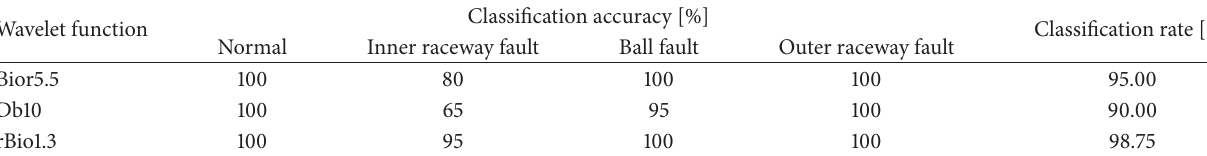
Table 8: The classification results under different wavelet functions.